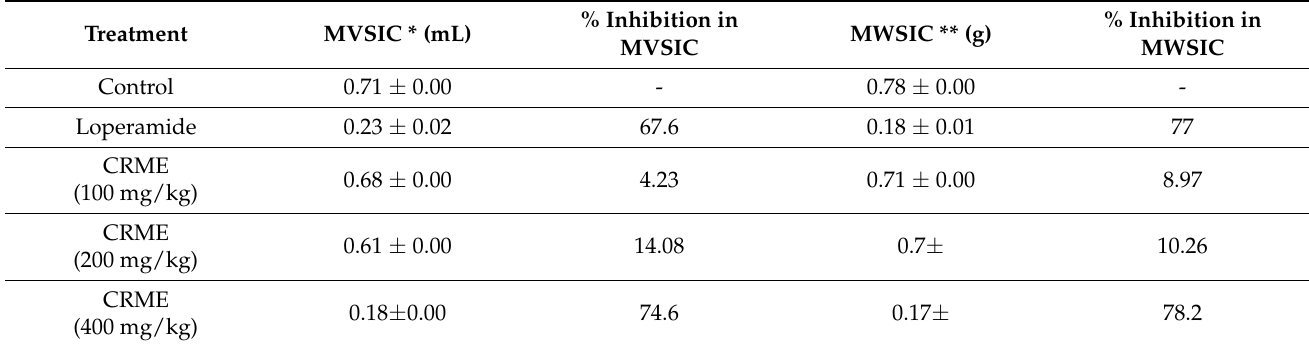
Table 6. Impact of CRME on the castor oil-induced enteropooling in mice.